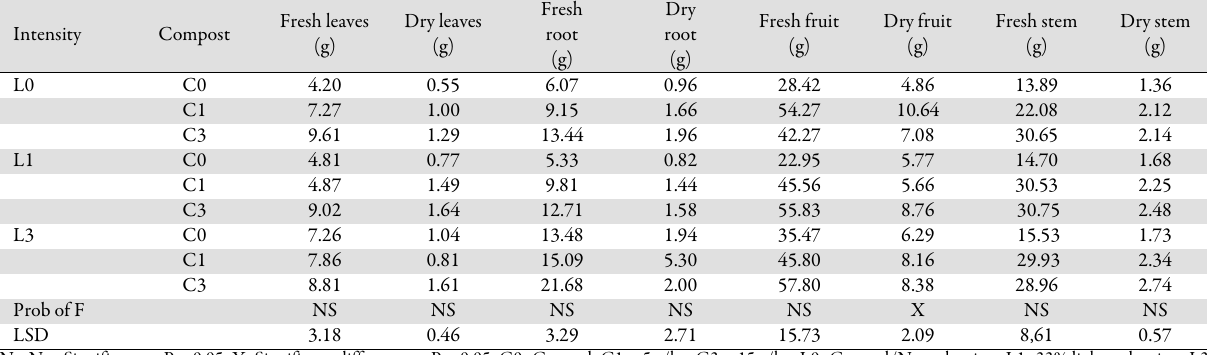
Table 11. Interactive effect of compost application on the yield parameters of okra on the field Intensity